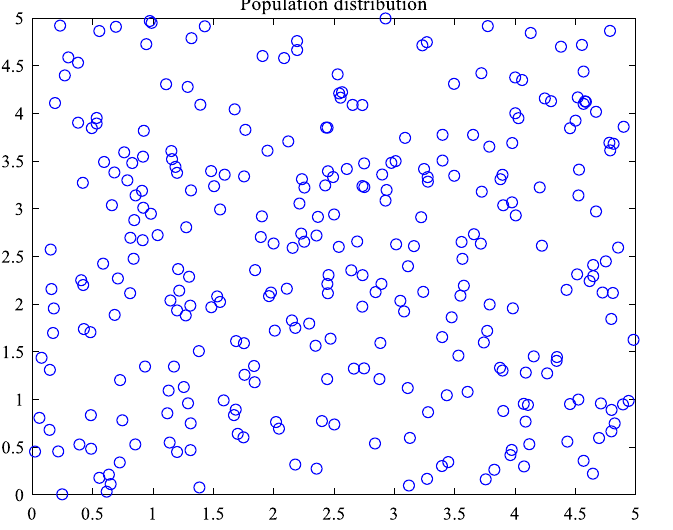
Figure 1. Random